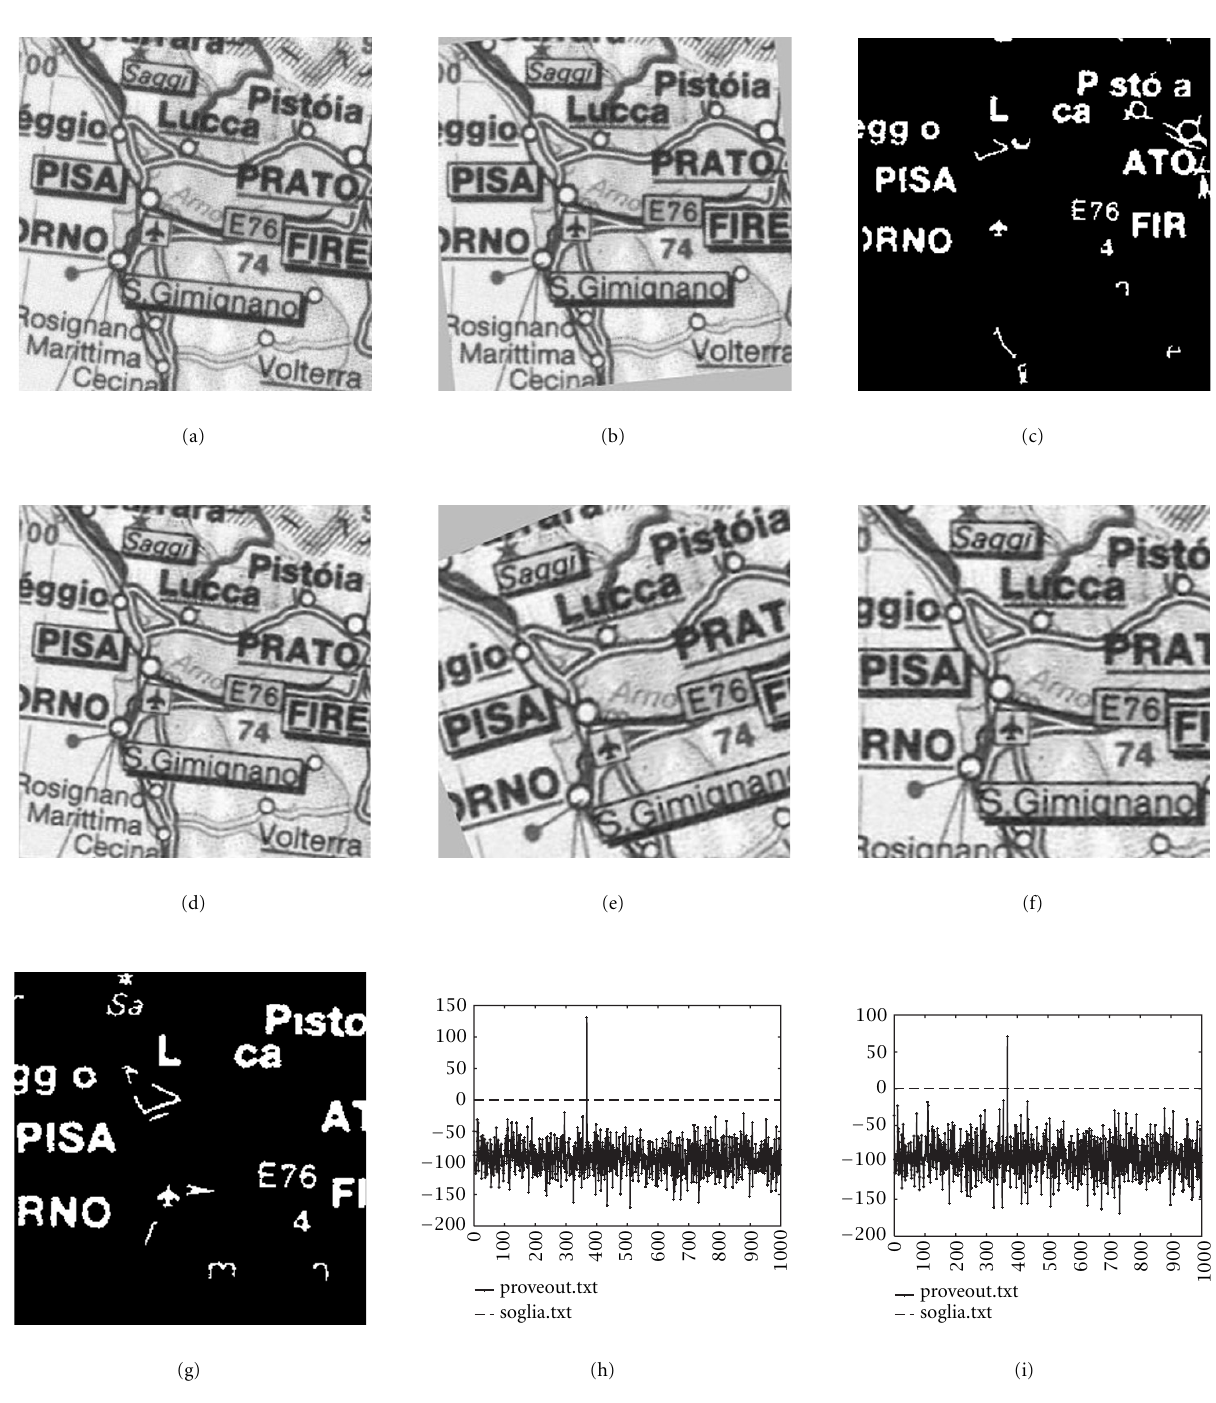
Figure 10: (a) Original map image ( 256 × 256 ); (b) original image after rotation normalization; (c) text extracted from the aligned original image; (d) final watermarked image; (e) particular of the watermarked image after resizing to 315 × 315, rotation of a 22 degrees angle and 70% quality JPEG coding; (f) attacked image after re-alignment; (g) text extracted from the attacked image; (h) detector response in the absence of attacks and (i) after